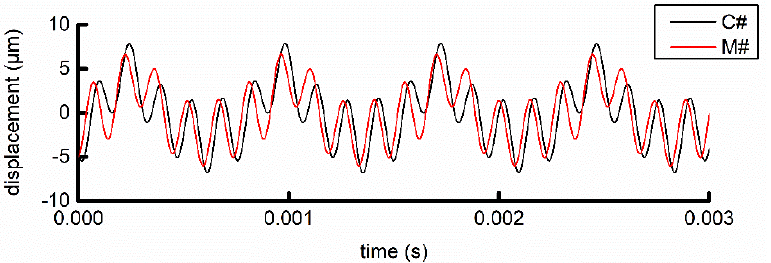
Figure 17. Blade tip transient response reconstructed from frequency domain results (perpendicular to chord).